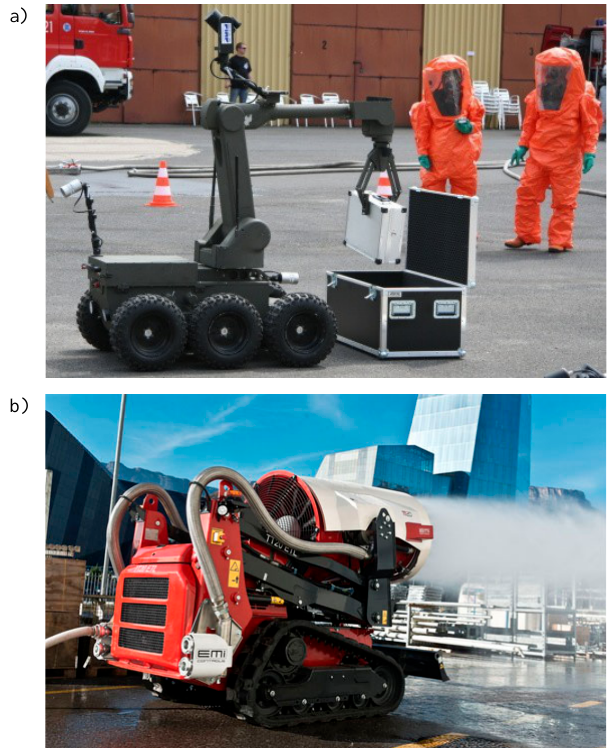
Fig. 1. Example of use UGV vehicles: a) operating in contaminated area [14], b) firefighting unmanned system [15] To comply its tasks, it is necessary to ensure quiet relo- cation and long range or long operating time in conflict